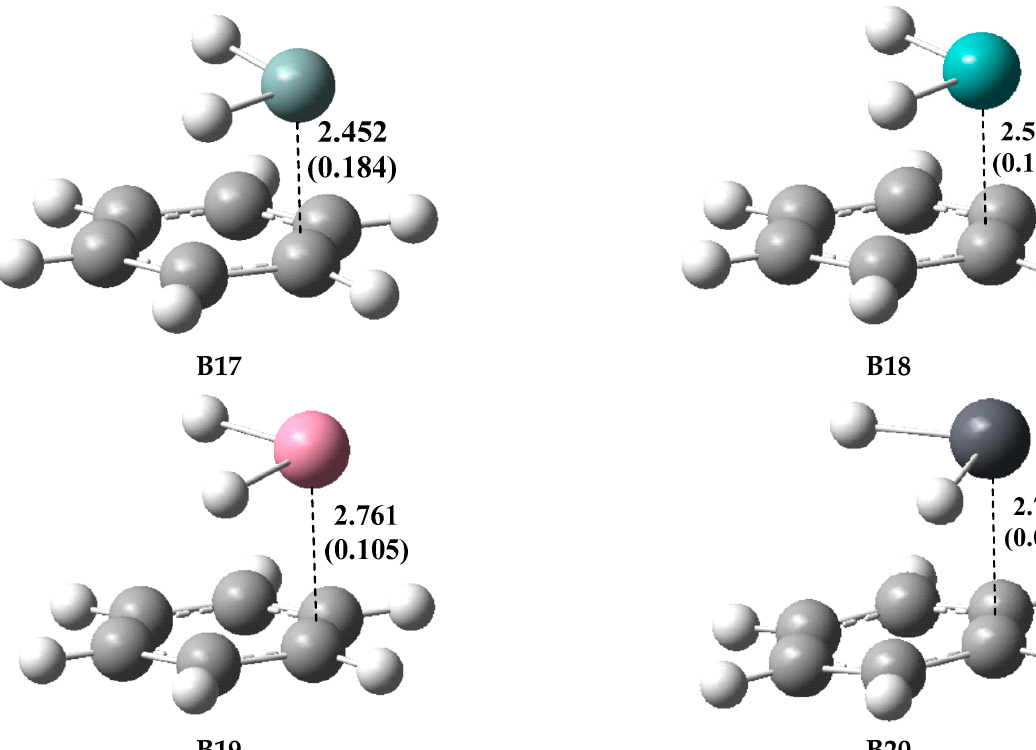
Table 5. Second-order perturbation stabilization energy ( E (2), in kJ/mol), charge transfer ( q CT , in e), electron density ( ρ , in a.u.), Laplacian ( ∇ 2 ρ , in a.u.), energy density ( H , in a.u.), local kinetic energy density ( G , in a.u.) and potential energy density ( V , in a.u.) at the BCP for type-B complexes.